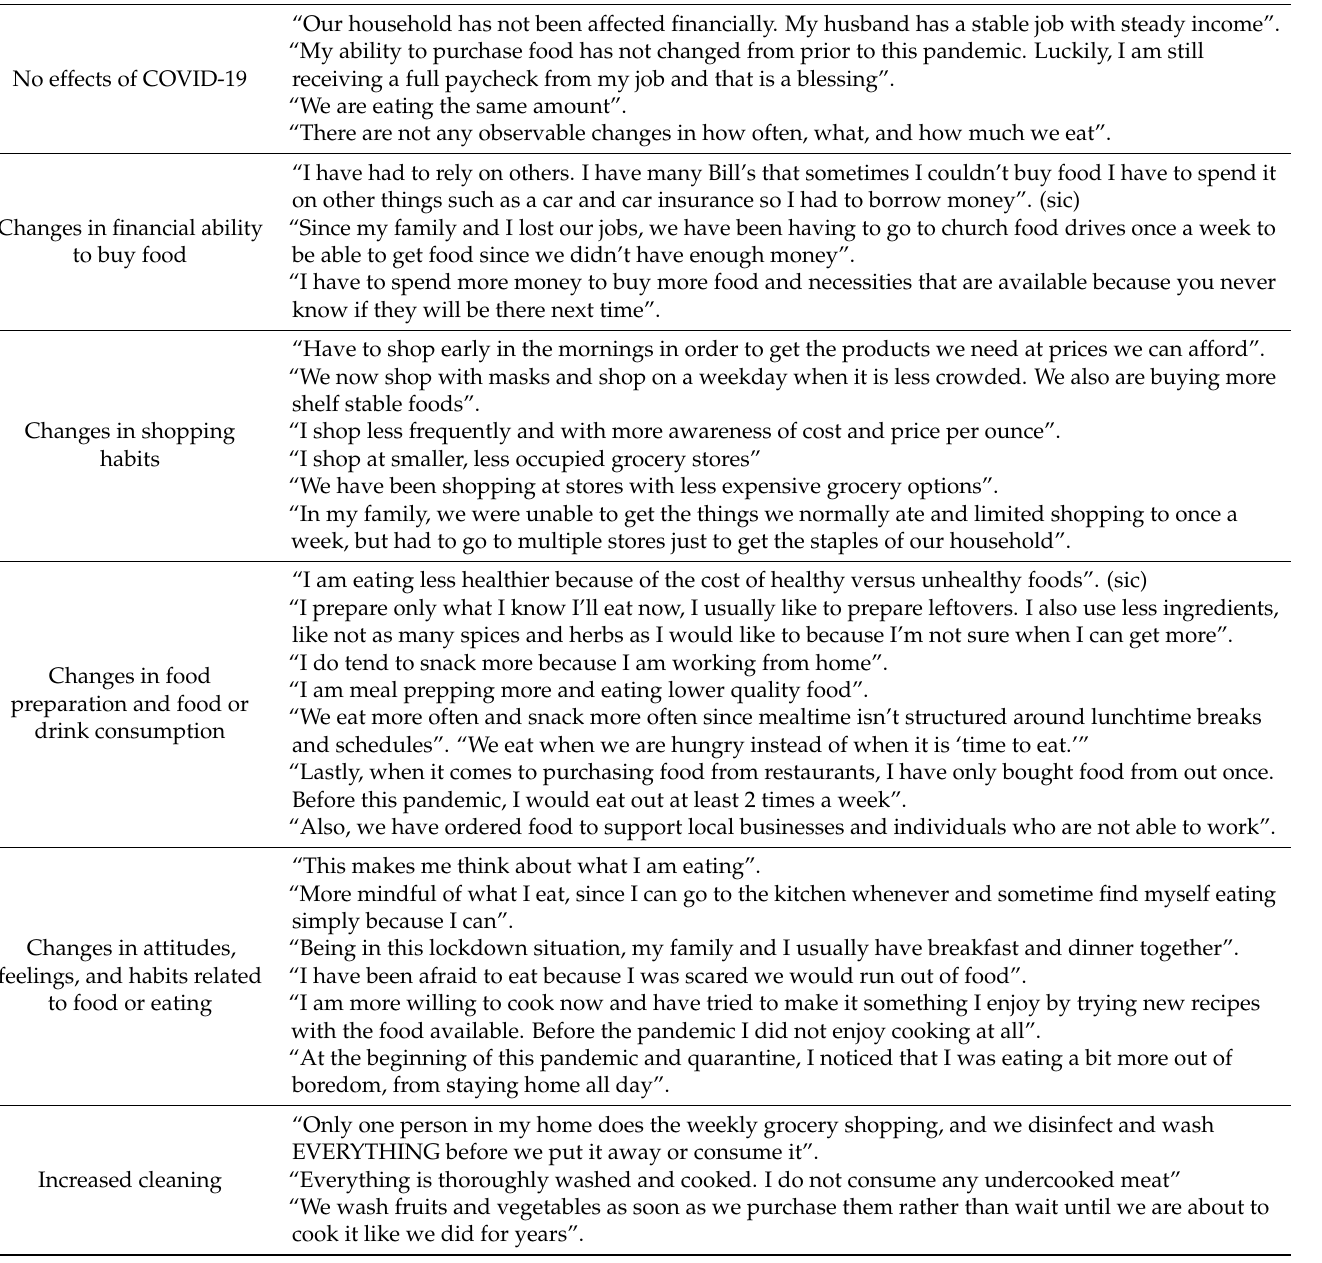
Table 3. Themes and Illustrative Quotes of College Students’ Experiences with Food During the Early COVID-19 Pandemic. Themes Illustrative Quotes